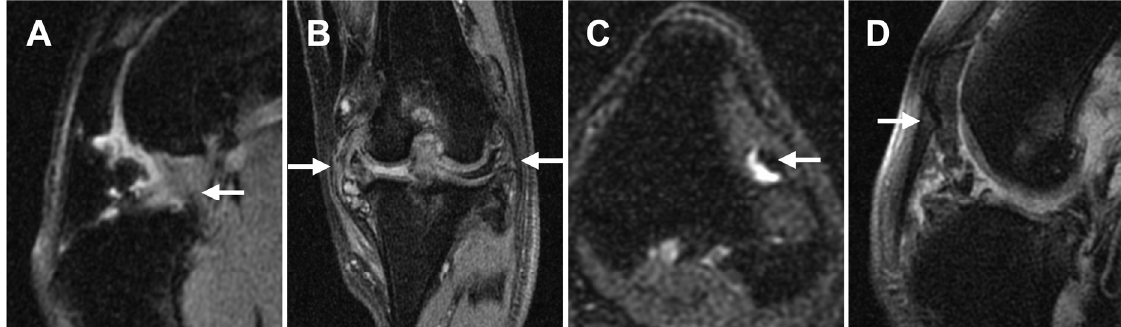
Figure 7. Representative MRI images of ligament/tendon lesions at each site. ( A ): Mixed intensities are seen in both CCL and CdCL (sagittal plane, PDW fs). ( B ): Both MCL and LCL are mildly thickened and have hyperintensities within the ligament (dorsal plane, PDW fs). ( C ): Focal hyperintensity is noted within the LDET with fluid accumulation surrounding the tendon (transverse plane, T2W fs). ( D ): Mixed intensity is noted adjacent to the distal patella at PL (sagittal plane, PDW fs). Abbreviations: CCL, cranial cruciate ligament; CdCL, caudal cruciate ligament; LCL, lateral collateral ligament; LDET, long digital extensor tendon; MCL, medial collateral ligament; PL, patellar ligament.